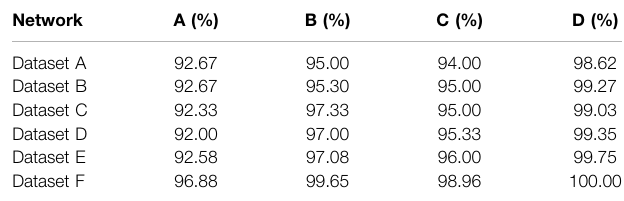
TABLE 9 | Ablation experiment